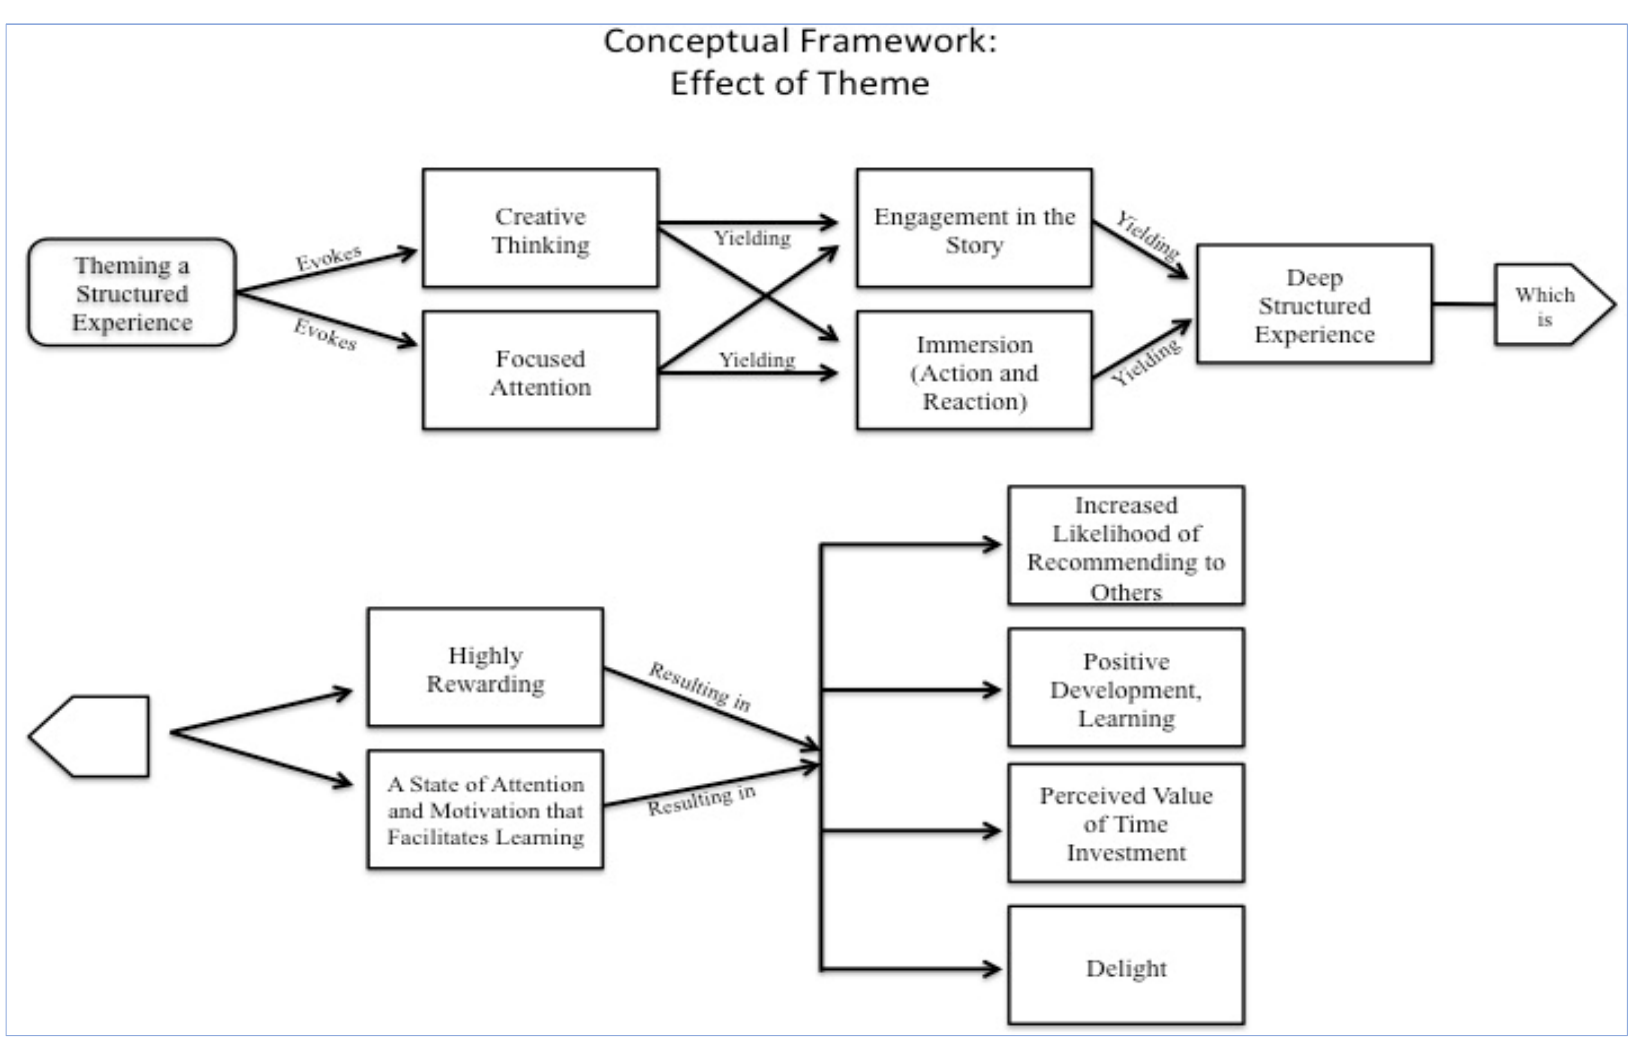
Figure 1. Author’s Conceptual model of Theme